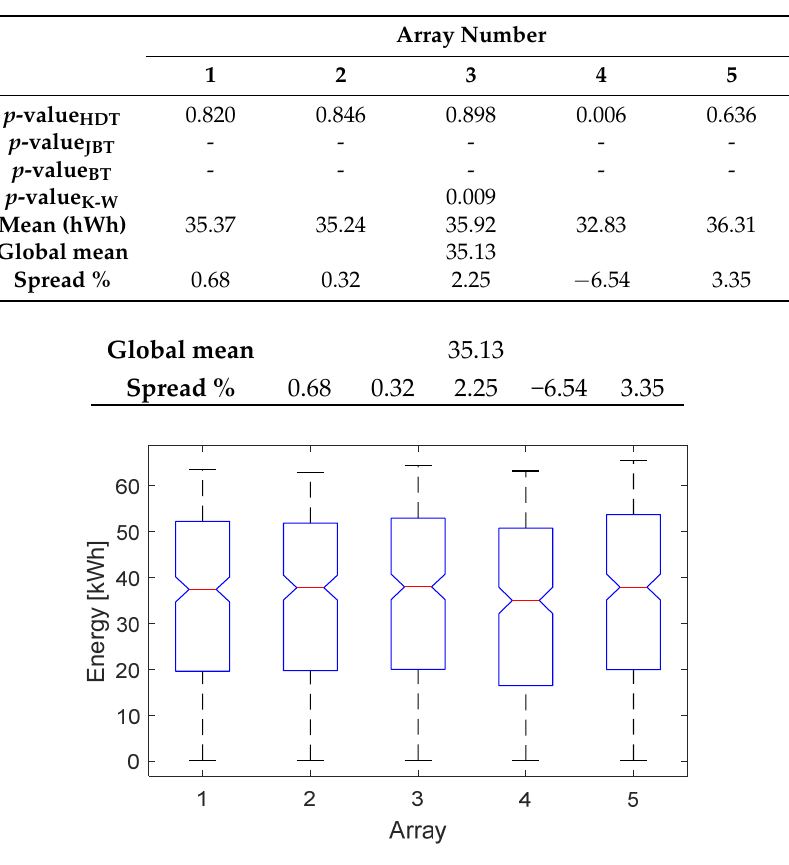
Figure 10. Box plot of K-W test of the five distributions for the one-year analysis.